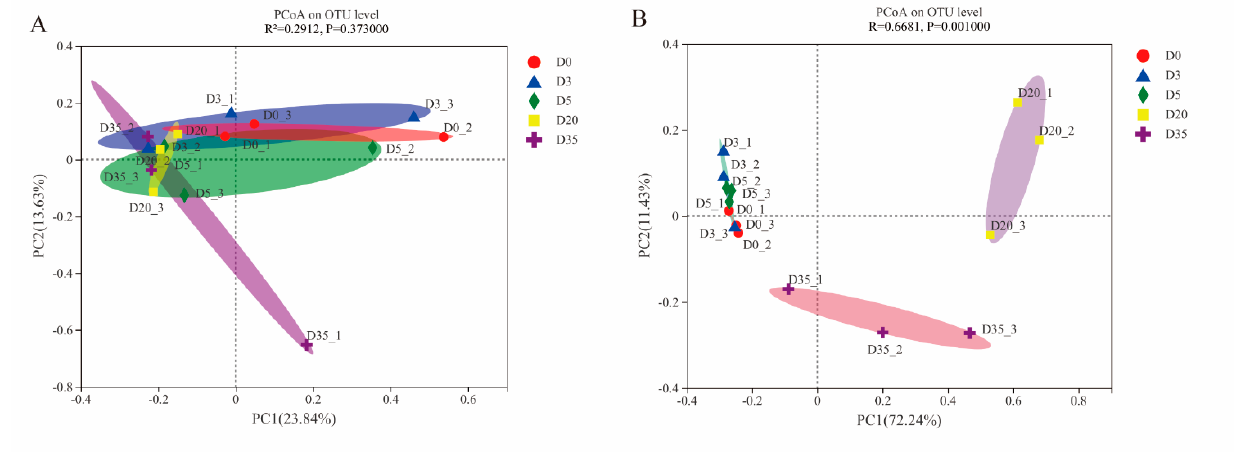
Figure 4. Dynamics of the microbial community in Aspergillus -type Douchi in different fermentation stages. Results of principal coordinate analysis (PCoA) of bacterial ( A ) and fungal ( B ) communities based on the Bray–Curtis distance matrix.